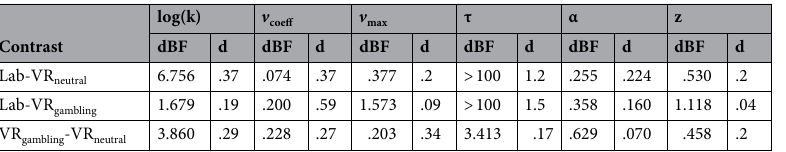
(Fig. 5a, d and Table 5).